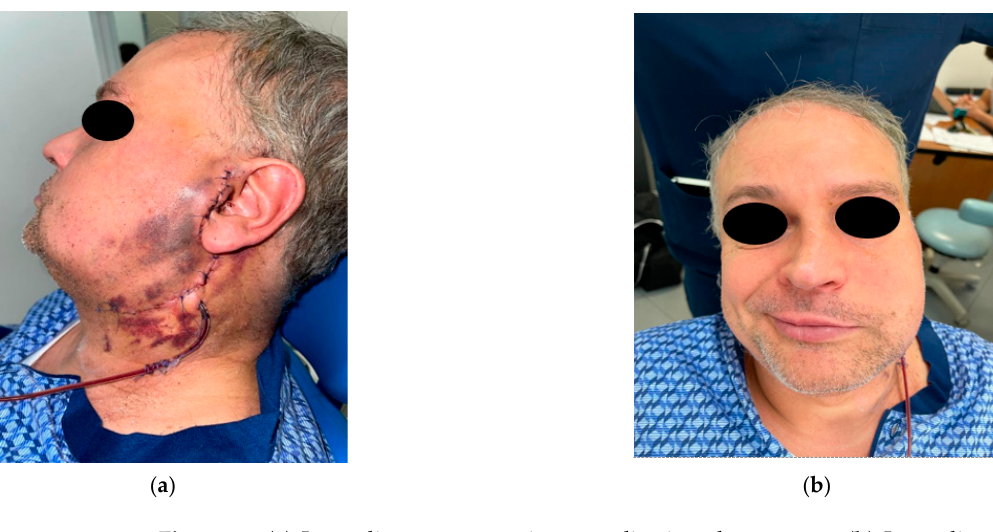
Figure 2. ( a ) Immediate postoperative complication: hematoma. ( b ) Immediate postoperative complication: facial nerve deficit.